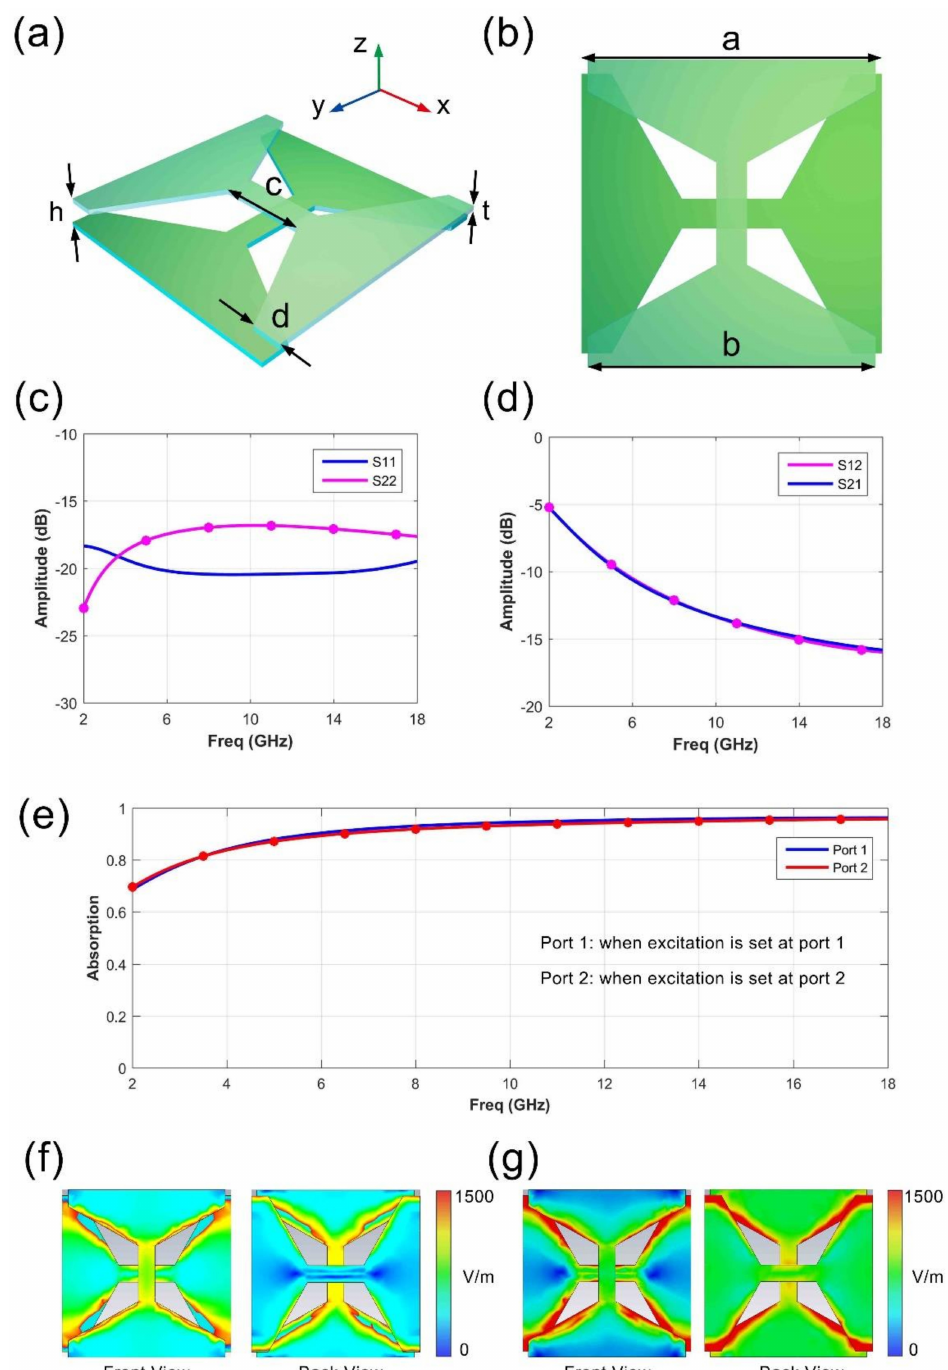
Figure 2. The designed element structure and the simulated results. ( a ) The detailed structure of the dual-layer metasurface. ( b ) The front view of the presented element. ( c , d ) The simulated reflection and transmission data of the element. ( e ) The absorption results when excitation is set at port 1 and 2. ( f , g ) The electric field distribution of the element when excitation is set at port 1 and 2, in which both the front and the back view is